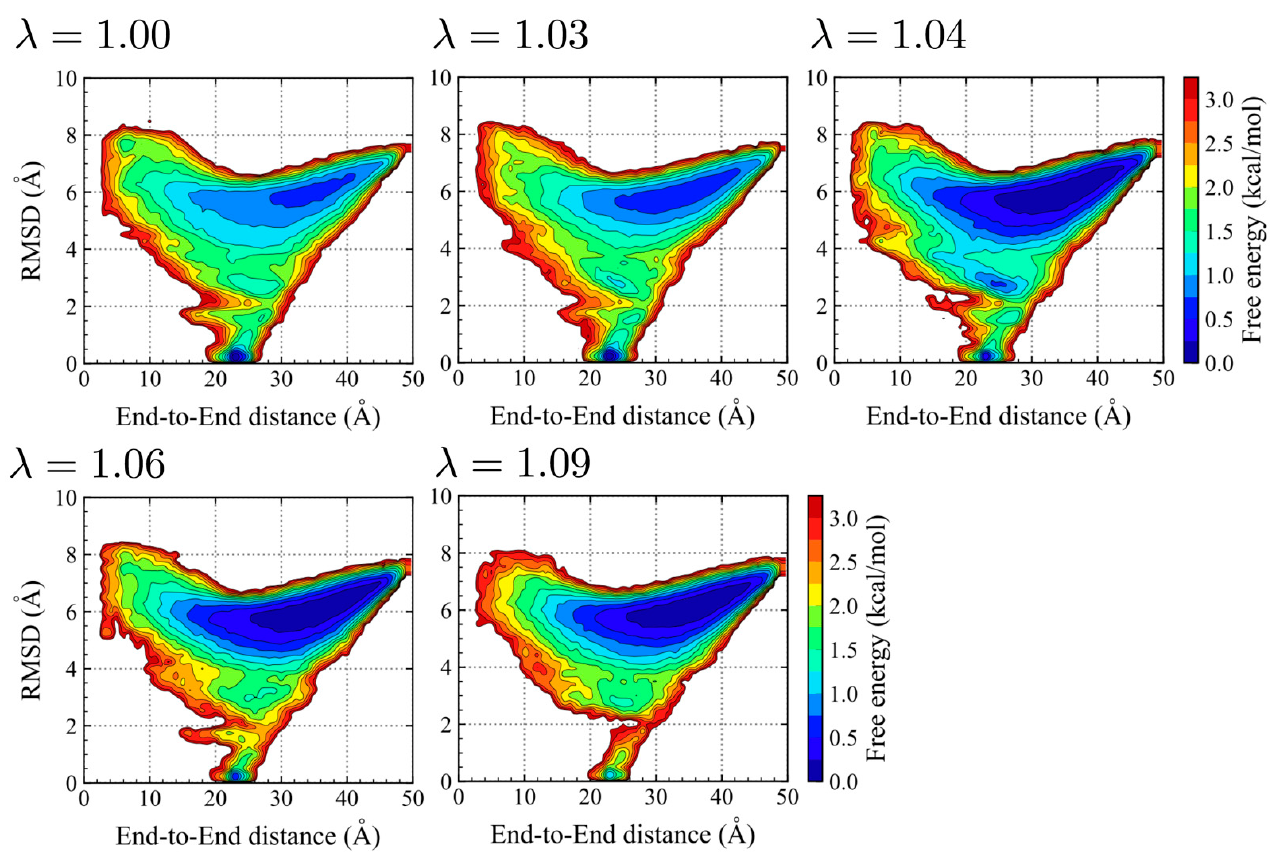
Figure 2. Two-dimensional potential of mean forces (2D-PMFs) of (AAQAA) 3 on the end-to-end distance, d , and the C 𝛼 root mean square deviation (RMSD) from the ideal helix for different λ = 1.00, 1.03, 1.04, 1.06, and 1.09.